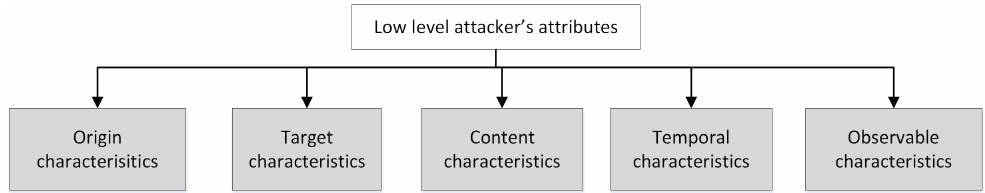
Figure 2. Main classes of the low-level